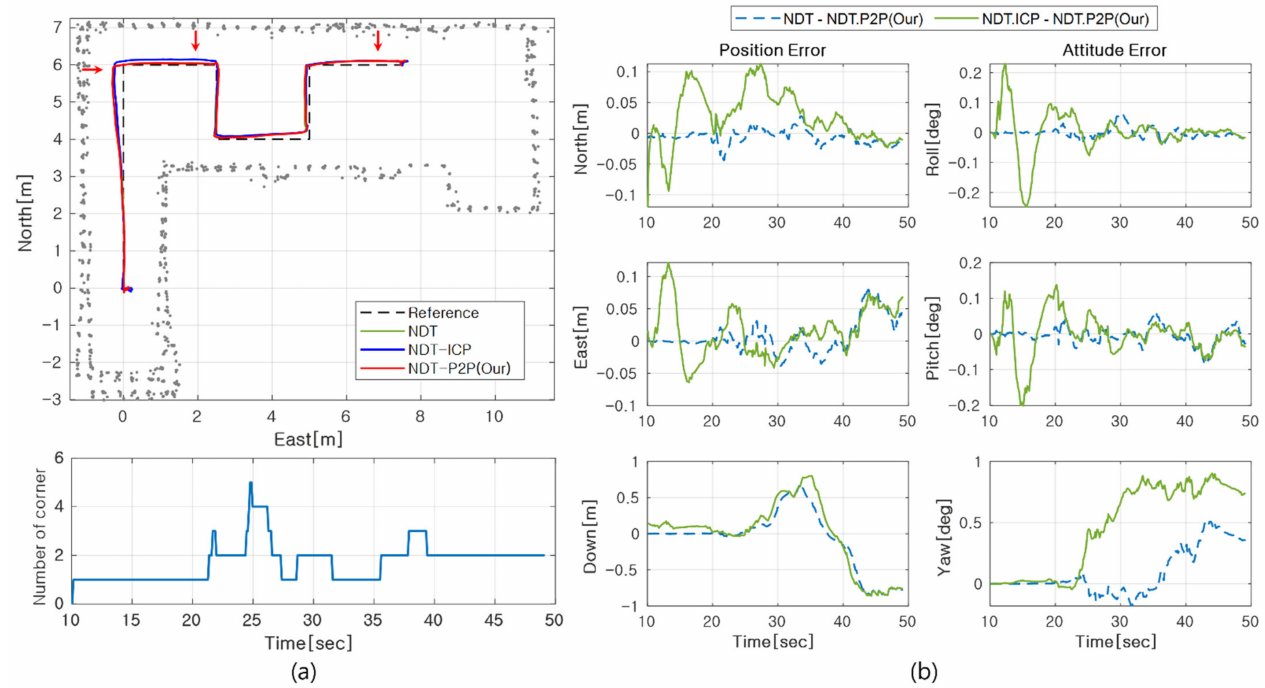
Figure 11. ( a ) Estimated position by algorithms and number of feature points extracted. ( b ) The error of position and attitude by NDT, NDT-ICP based on